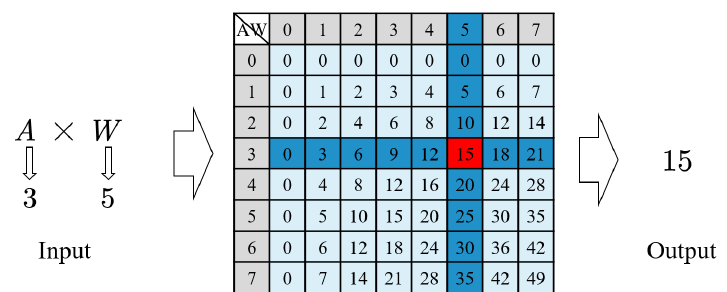
Figure 1. Multiplication process based on LUT. The multiplication result is obtained by searching in the LUT according to the input data pair. A and W represent activation and weight,